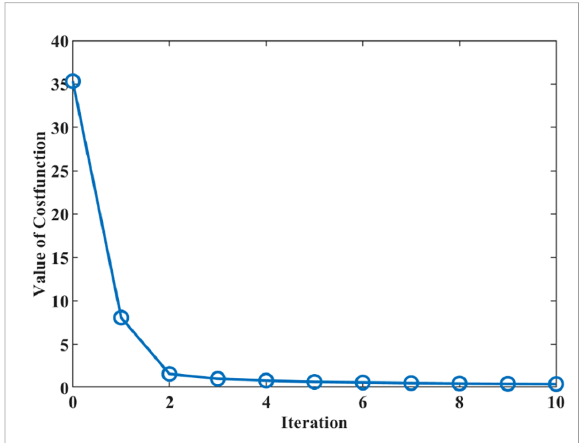
FIGURE 3 The cost function value decreases with iterations in the twin experiment with perfect observations on the 1°×1°